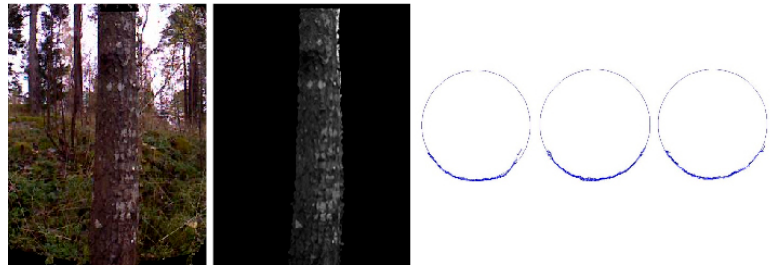
Figure 2. One example of diameter determination. Left : original RGB image, extracted trunk skeleton and identified position of the three markers. Right : circle fitting to the points at the height of the markers.